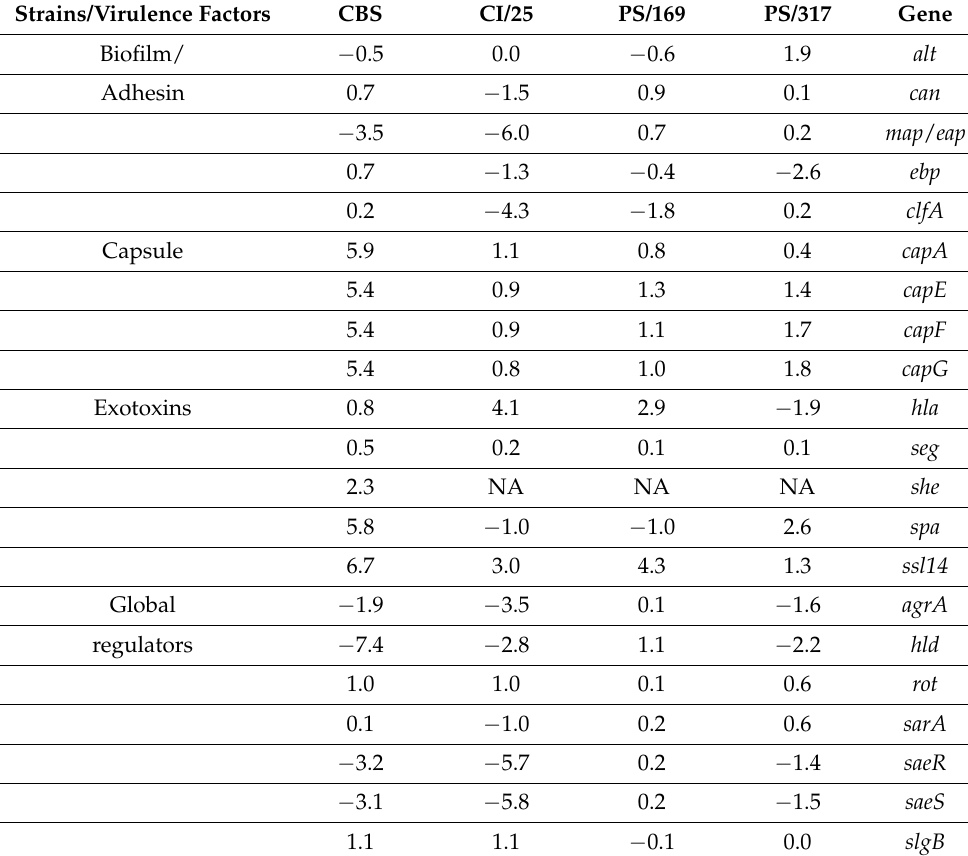
Table 2. RNAseq-based differential expression (Log2 Fold change). Selected virulence factors (repre- sented genes) in PCs against TSB of tested S. aureus